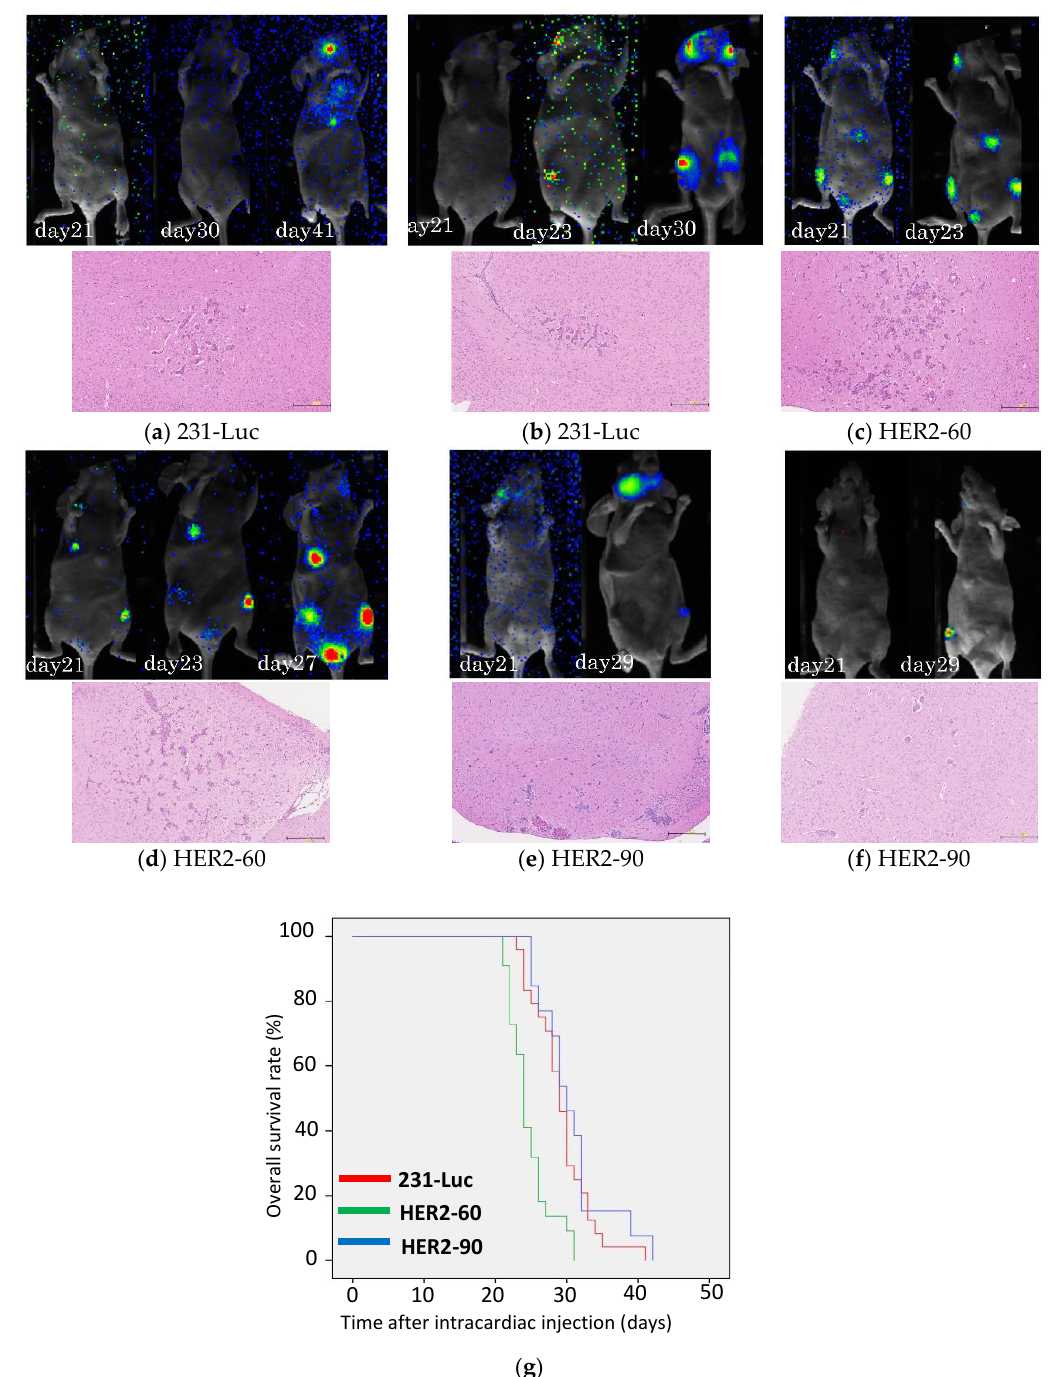
Figure 1. Heterogeneous HER2 expression is associated with a short survival time in metastatic breast cancer. ( a – f ) Representative bioluminescence images of mice after intracardiac injection ( upper panel ). H&E staining of formalin-fixed, paraffin-embedded metastasized brain sections. Scale bar, 250 μm ( lower panel ). ( a , b ) Injected with 231-Luc cells; ( c , d ) injected with HER2-60 cells; ( e , f ) injected with HER2-90 cells; ( g ) survival curves of mice after intracardiac injection of 231-Luc ( n = 24), HER2-60 ( n = 22), and HER2-90 ( n = 13) cells (231-Luc vs . HER2-60; p < 0.001; 231-Luc vs. HER2-90; p = 0.34).